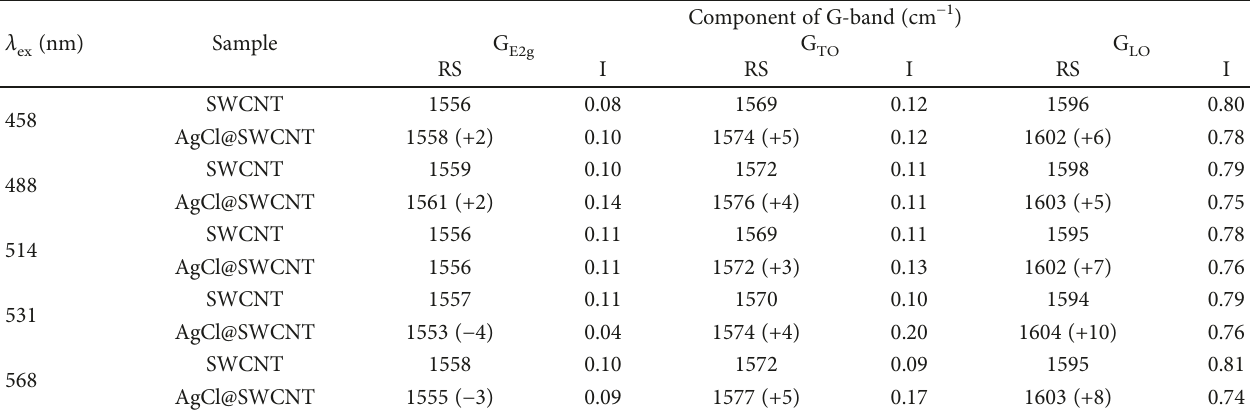
Table 2: The peak positions (RS) and relative area intensity (I) of the components of the G-band (G the pristine and AgCl- fi lled SWCNTs. The shifts of the components of the fi lled SWCNTs relative to the position of the pristine nanotubes are given in